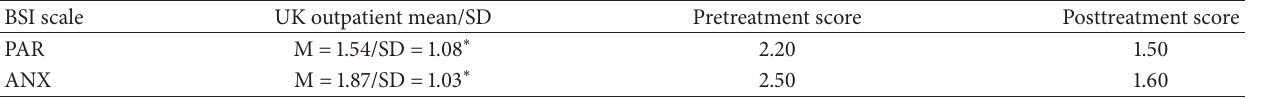
Table 3: BSI pretreatment assessment and posttreatment evaluation scores for the